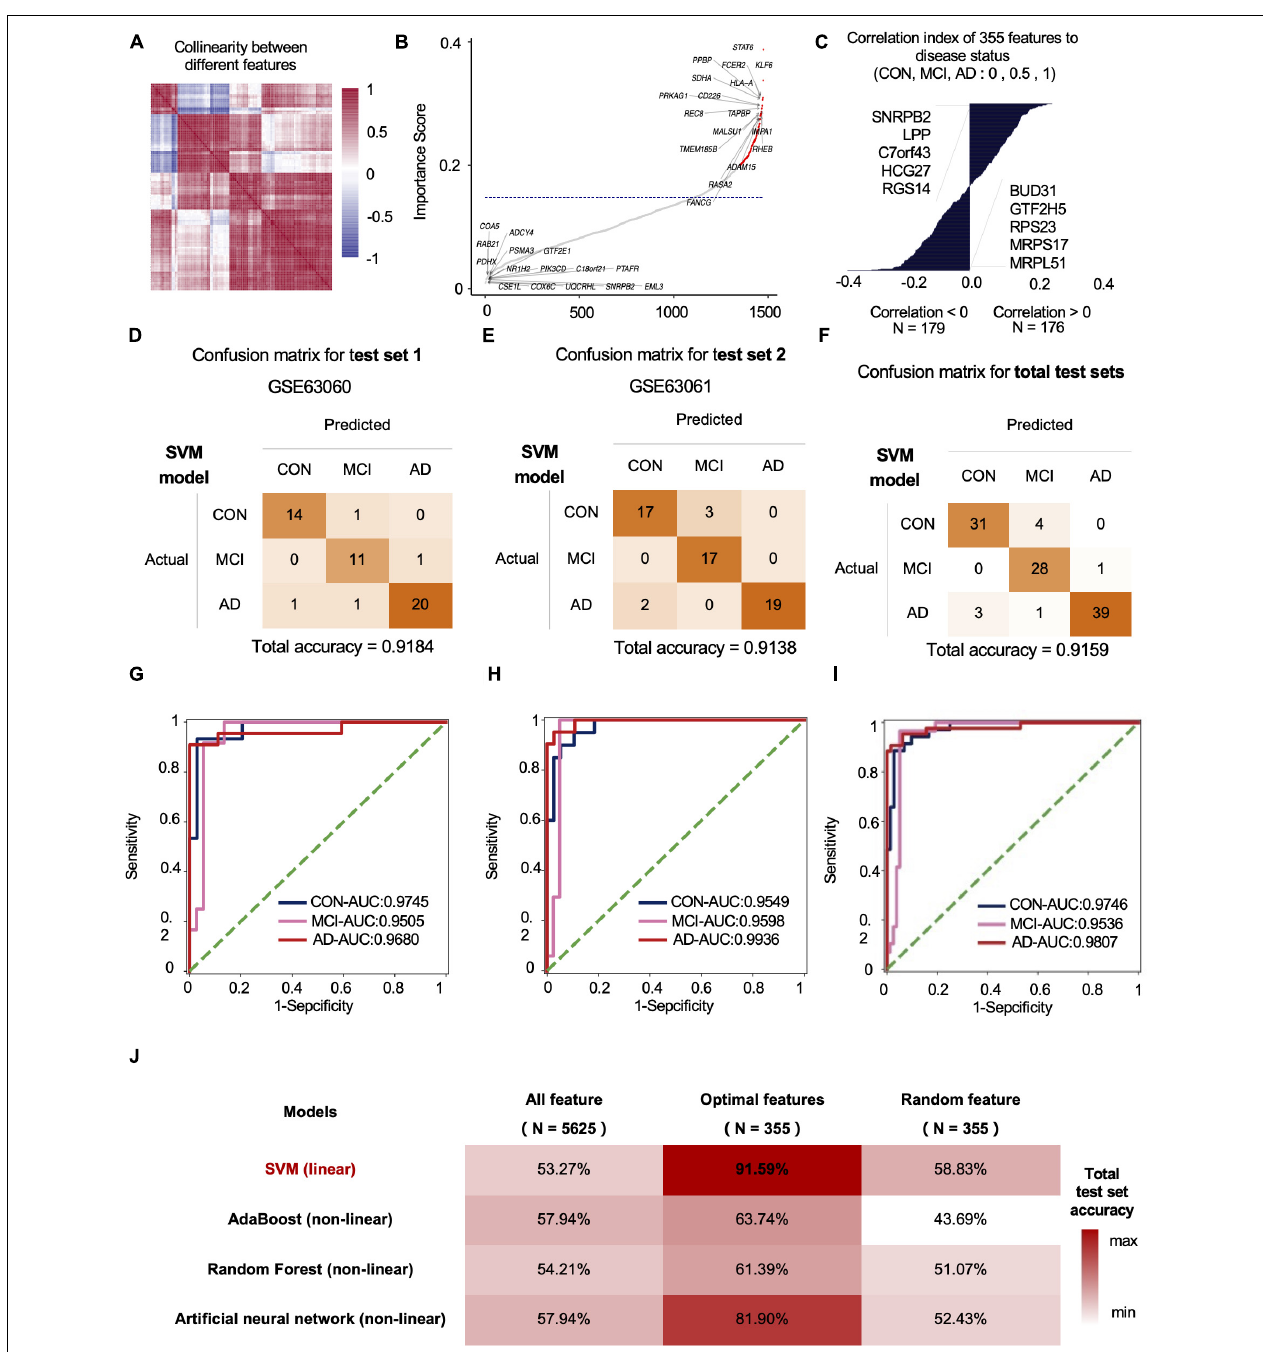
FIGURE 2 | The mRNA data-based feature engineering and AI-modeling of CON, MCI and AD. (A) Correlation of each feature, correlation threshold 0.9. (B) Filter lower importance features, the y-axis represents the standard deviation, dashed line is the cutting threshold, the x-axis represents the features in order of importance (ascending). (C) Correlation between features and labels, show top five features. (D–F) Confusion matrix of two independent test sets. (G–I) ROC curve of the model developed by optimal feature in two independent test sets. (J) Compare the prediction accuracy on test set between different models and features.